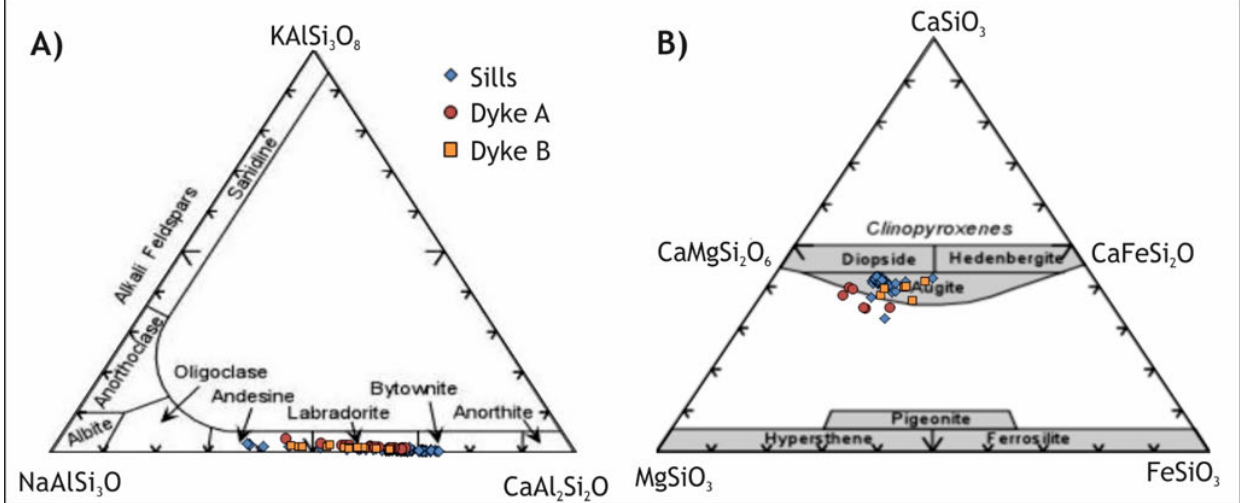
Figure 5: Results from mineral chemistry analysis of dykes (red circles and orange squares) and sills (blue triangles) collected from Leirfjall. [A] Compositional classification of feldspars. [B] Compositional classification of pyroxenes.